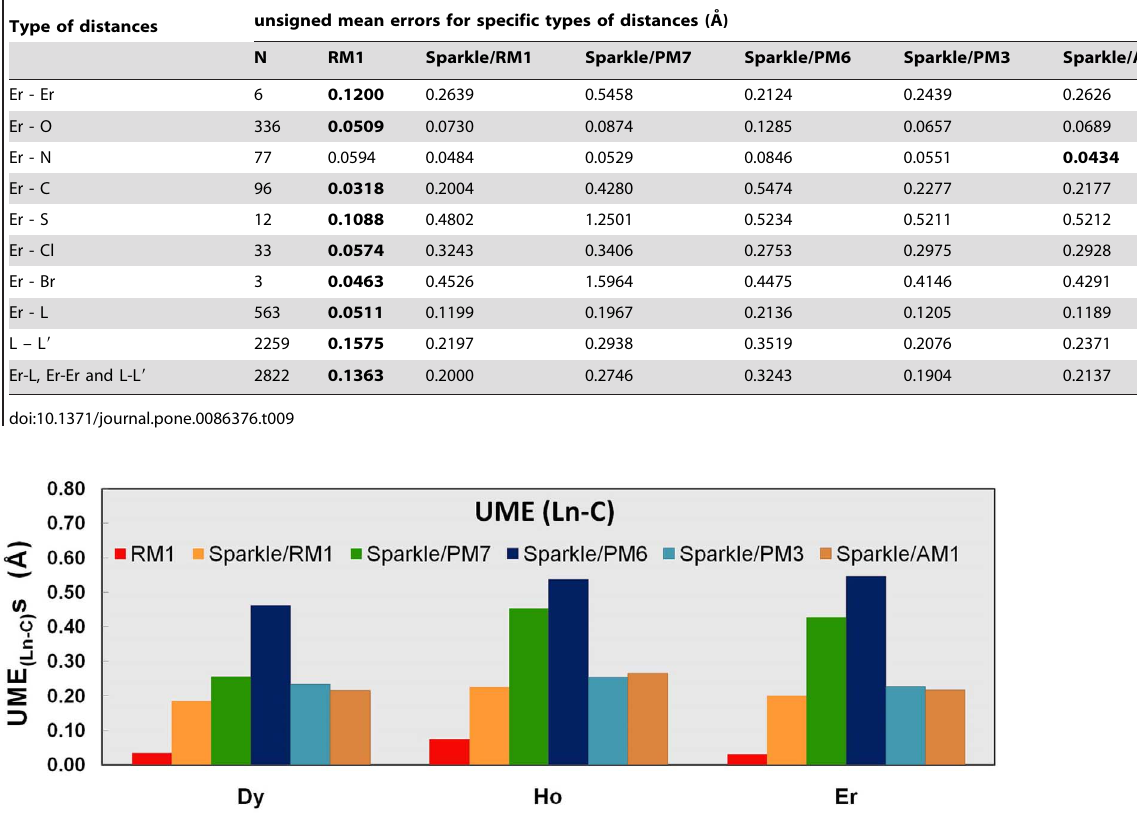
Figure 4. UME (Ln-C) obtained using the RM1 model for the lanthanides and all five versions of the Sparkle Model: Sparkle/RM1, Sparkle/PM7, Sparkle/PM6, Sparkle/PM3 and Sparkle/AM1 for all complexes of the universe set for each of the lanthanide trications: Dy(III), Ho(III) and Er(III). The UMEs are calculated as the absolute value of the difference between the experimental and calculated Ln- C interatomic distances, summed up for all complexes, for each of the lanthanides.